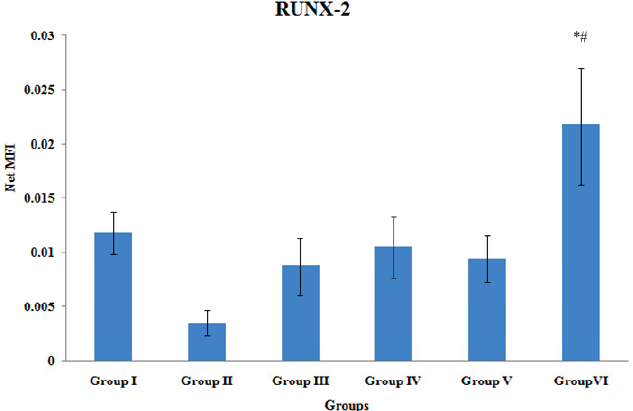
Figure 4. RUNX-2 Gene Expression. Samples were normalized to GAPDH MFI (Median Fluorescence Intensity). Values were expressed as mean ± SEM. Group I: sham-operated group, Group II: ovariectomized control group, Group III: ovariectomized+Estrogen, Group IV: ovariectomized+Lovastatin, Group V: ovariectomized+Tocotrienol, Group VI: ovariectomized+Tocotrienol+Lovastatin. * Indicates a significant difference ( p < 0.05) compared with the group II. # Indicates a significant difference ( p < 0.05) compared with the group